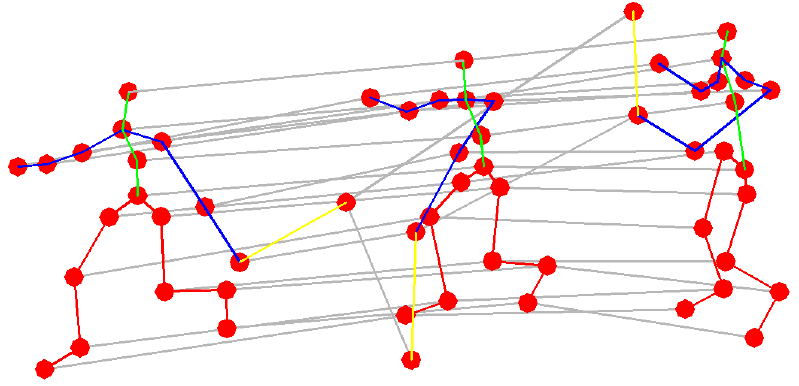
Figure 1. A spatial temporal graph of skeleton. Red dots represent joints and other characteristic points. Red lines represent connections between points within the lower limbs, blue—upper limbs, green—spine, yellow—tennis